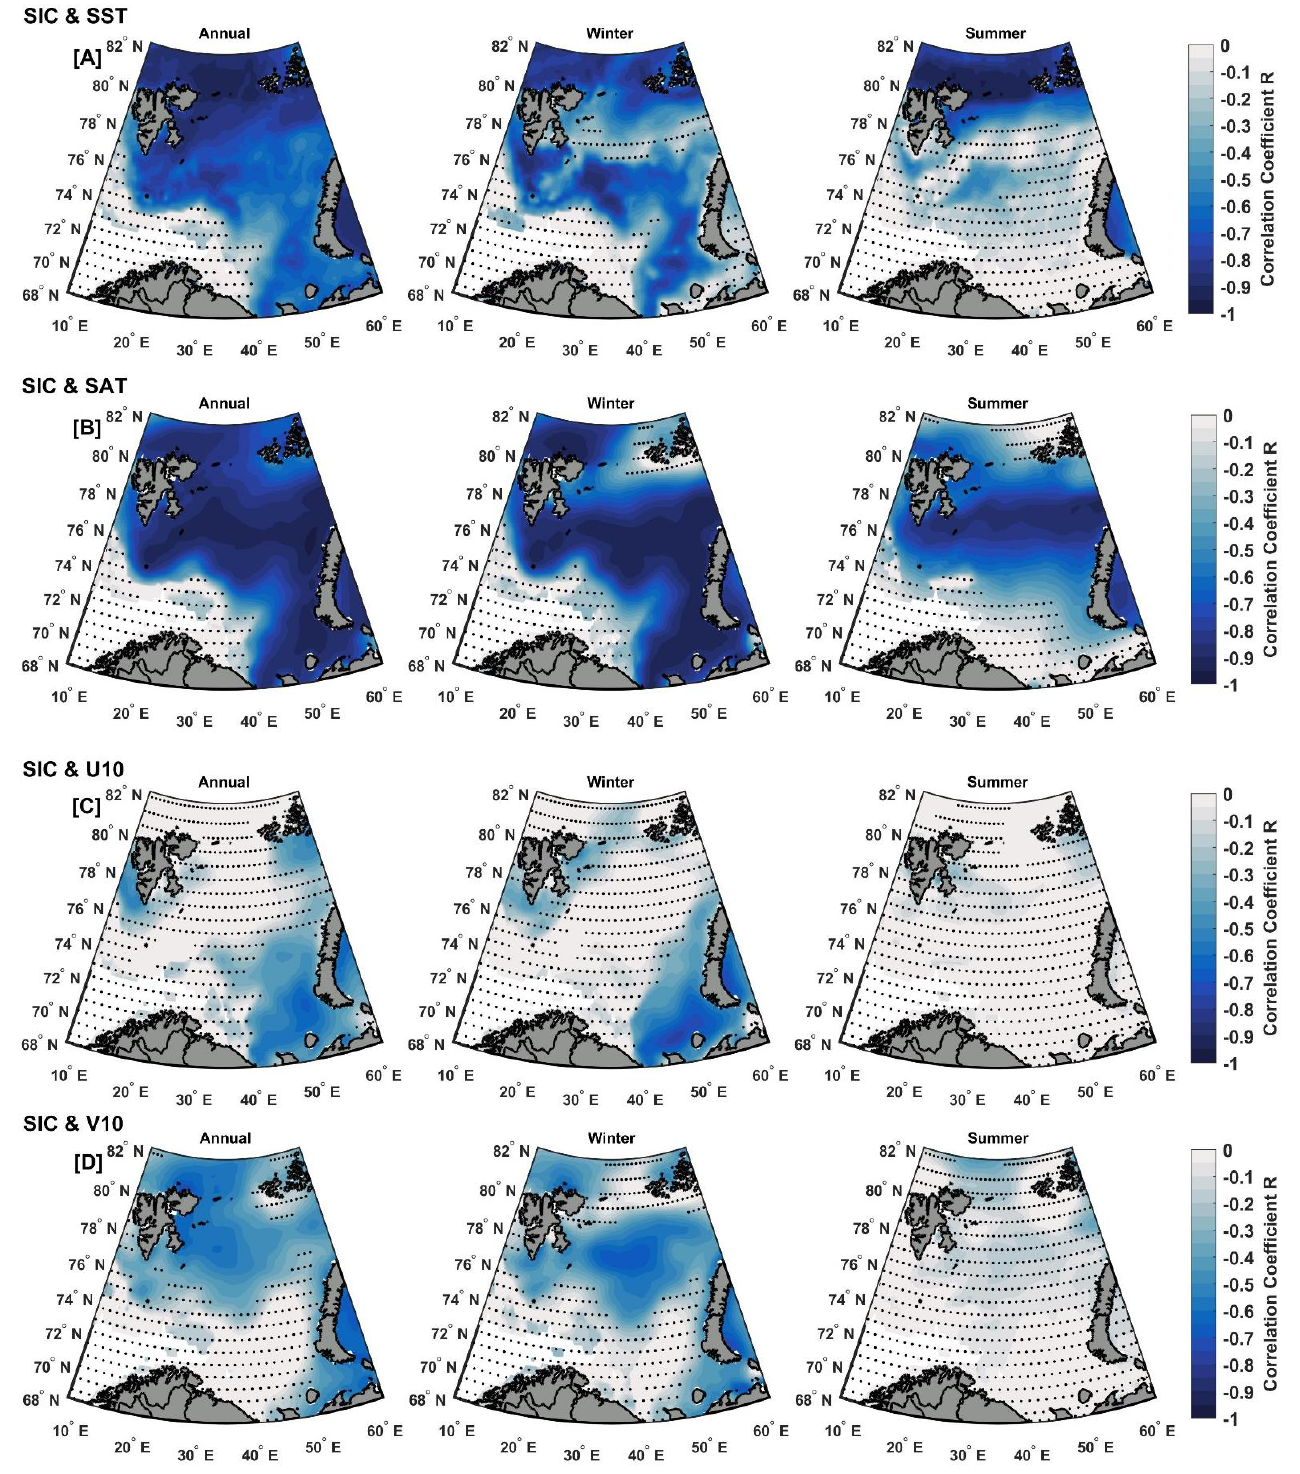
Figure 15. Spatial distribution of correlation coefficients between SIC and ( A ) sea surface tempera-